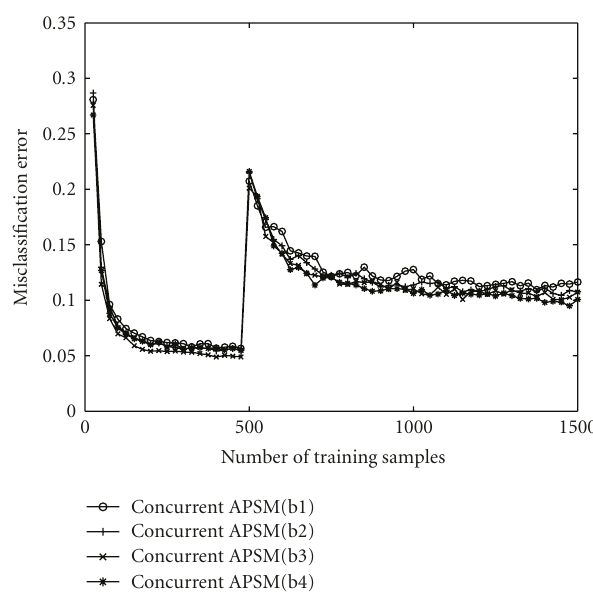
Figure 8: A channel switch occurs at time n = 500, from H 1 to H 2 , for the LTI system in Figure 3. The variance of the Gaussian kernel function is σ 2 : = 0 . 5. The parameter q = 16. These curves correspond to di ff erent values of the pair ( α , L b ), and more specifically, “APSM(b1)” corresponds to (0 . 9,150), “APSM(b2)” to (0 . 75,200), “APSM(b3)” to (0 . 5,500), and “APSM(b4)” to (0 .